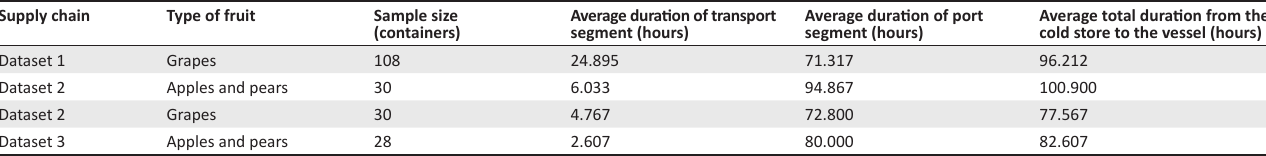
TABLE 1: Average duration of transit from the cold store to the vessel. Supply